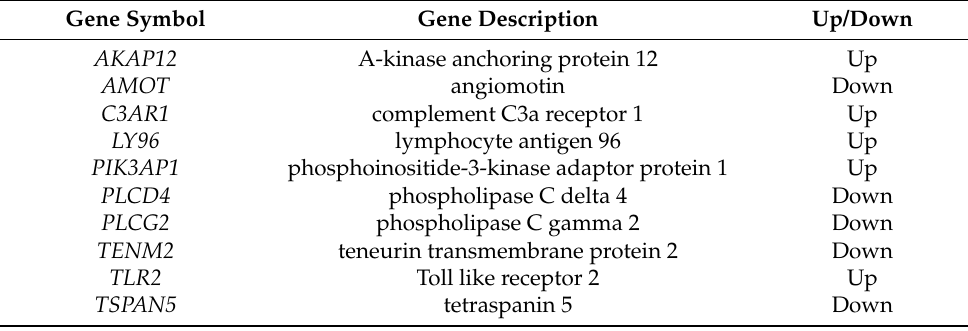
Figure 4. Overall protein – protein interaction network of top 10 genes with the highest connectiv- ity. Table 1. Top 10 hub genes with higher degrees of connectivity .